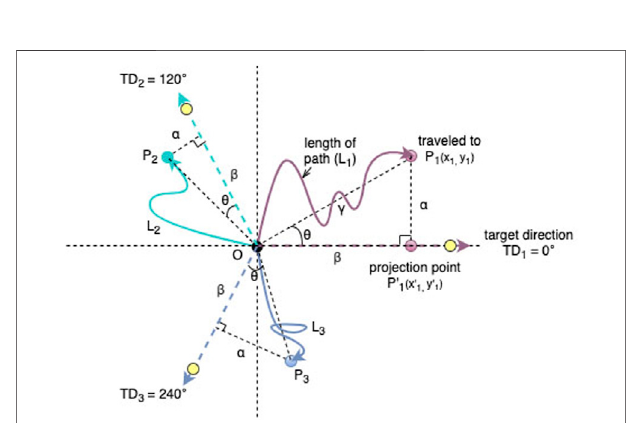
FIGURE 5 | Illustration of the fi tness function. We use 3 target points (yellow dots) to mark 3 target directions TD 1 =0 ° (purple dotted line), TD 2 =120 ° (green dotted line) and TD 3 =240 ° (blue dotted line). Point O is the starting position of the robot, p 1 ( x 1 , y 2 ) is an example of the end position ofarobotlearningtargetdirection T 1 .Thepurpleline L 1 istheactualtravelpath between(0,0)and P 1 .Thepoint P 1 ′ ( x 1 ′ , y 1 ′ ) istheprojectionof P 1 onthetarget direction T 1 . Same with the actual travel path L 2 and L 3 for T 2 and T 3 respectively.